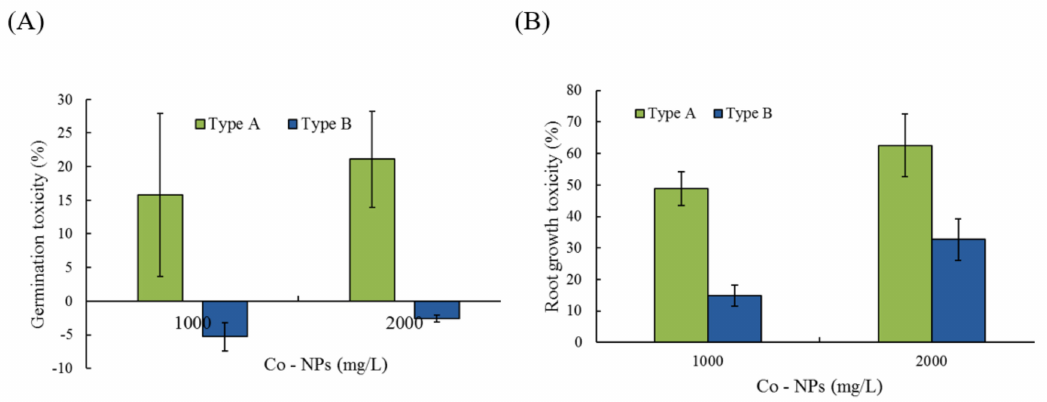
Figure 9. Comparisons of the toxic effects of the different sizes of Co-NPs on plant activity: ( A ) toxicity of seed germination, ( B ) toxicity of root growth of Lactuca. Comparisons were made based on the relative activity of the control set: no toxicity and the without Co-NP amended condition (soluble cobalt metal concentrations: 64 ± 14 µ g / L and 439 ± 135 µ g / L for the small particles (type A) and 5 ± 0.6 µ g / L and 8 ± 1 µ g / Lforthelargeparticles(typeB)withexposuresof1000mg / Land2000mg /